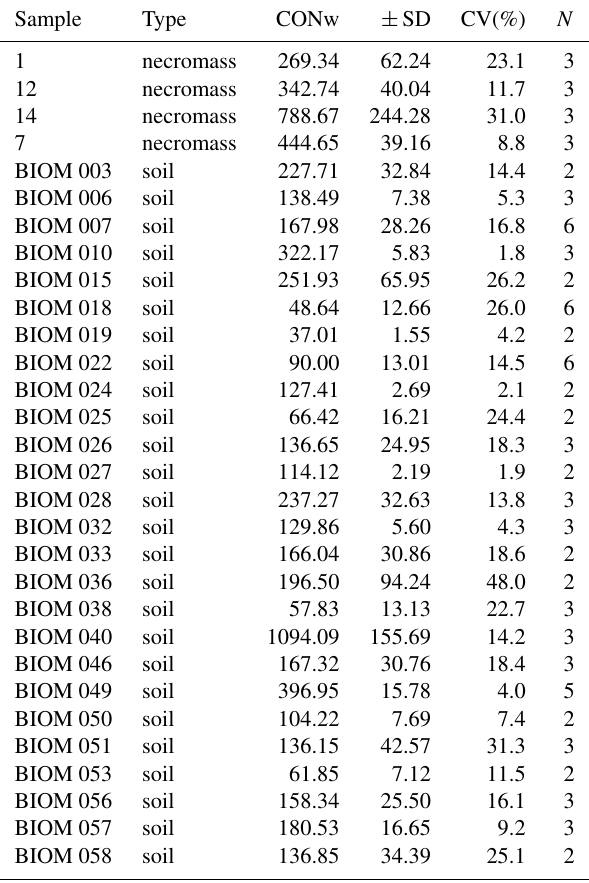
Table A1. Sample replicates table, denoting the replicate sample field code (sample), replicate sample type (type), the replicate sample average n -alkane concentration (in ngg − 1 ) of dried sample, CONw; the associated standard, CV(%; and the number of replications done, N